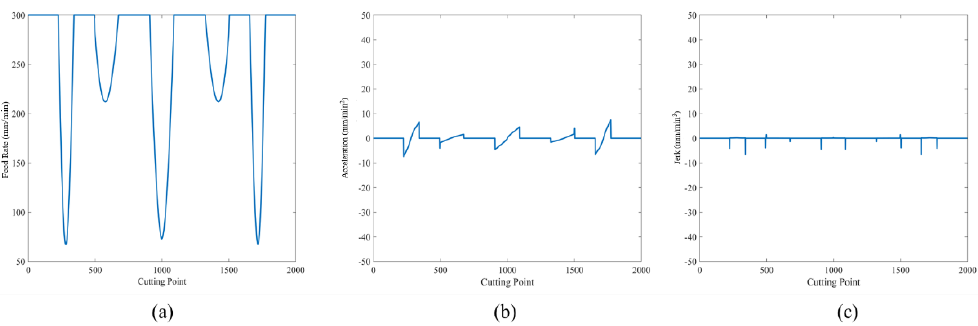
Figure 18. Cutting trident shape using method by Luan et al. [9]: ( a ) feed rate, ( b ) acceleration, and ( c ) jerk.